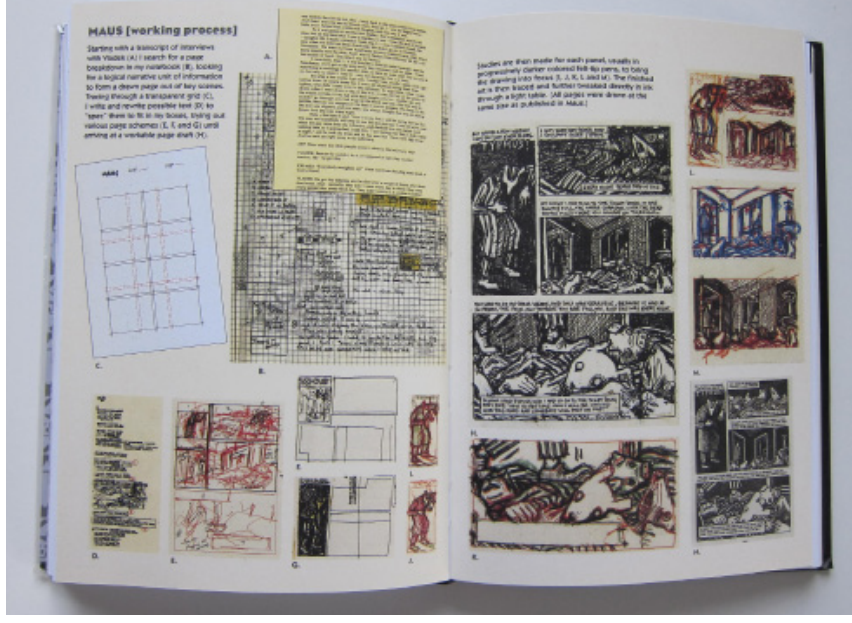
FIGURE 3 | Pages in Meta Maus – A Look Inside a Modern Classic by Art